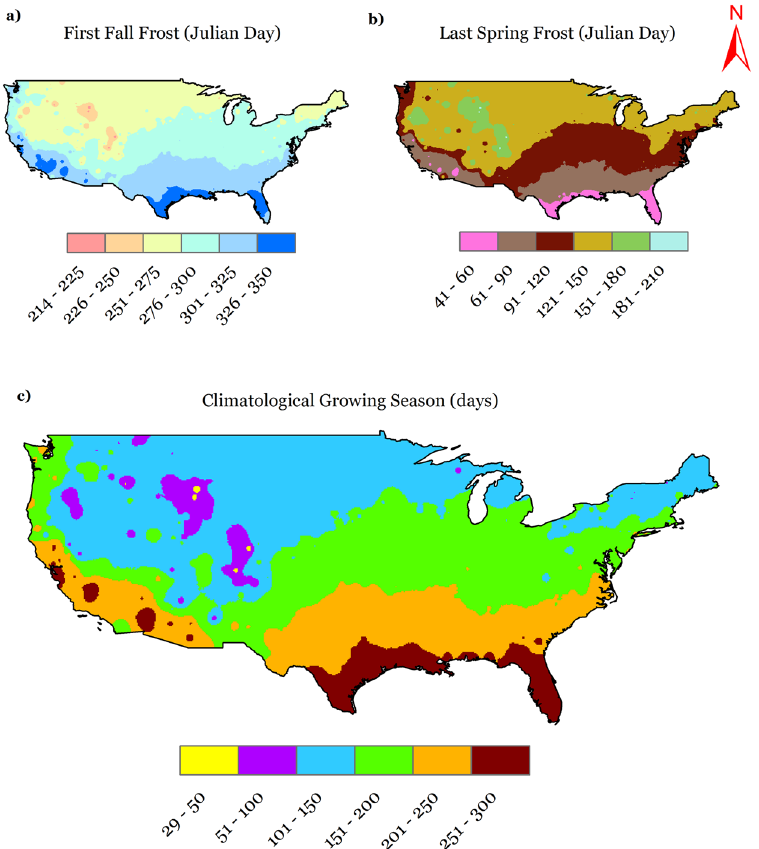
Figure 5. Spatial distribution of long-term average (1900–2014) ( a ) first fall frost (FFF); ( b ) last spring frost (LSF) and ( c ) climatological growing season (CGS) across CONUS. We created the maps using ESRI ArcMap 10.4.1 software